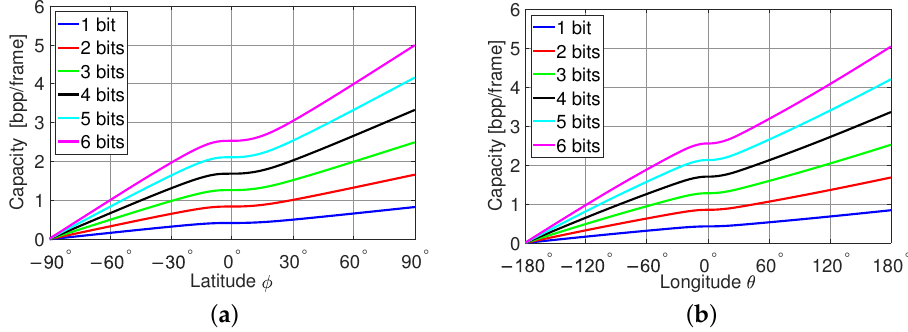
Figure 14. Capacity of viewing direction based data hiding: ( a ) Latitude φ , ( b ) Longitude θ